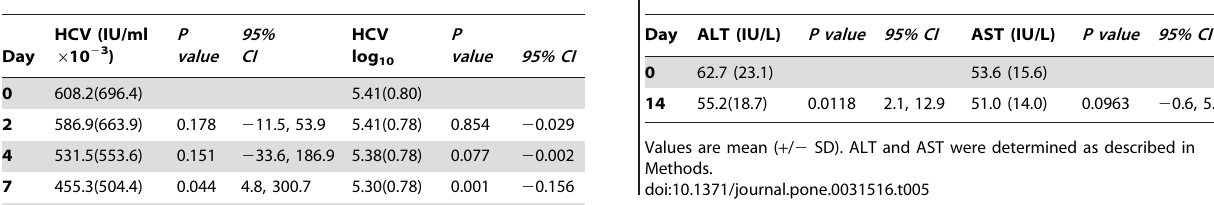
Table 5. Effects of Pioglitazone on liver injury indicators.